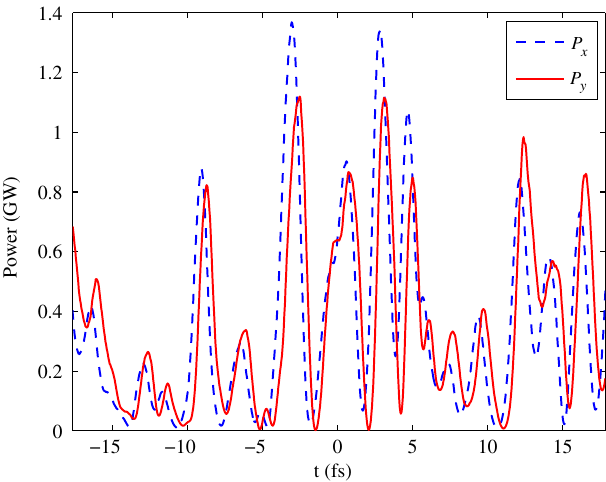
FIG. 3. (Color) Amplitude of the time correlation j g 1D simulations (black star) and from Eq. (23) (red solid curve). The degree of polarization is equal to j g For comparison, the blue dashed curve shows an estimate of the polarization by Eq. (24) (see text for more details).